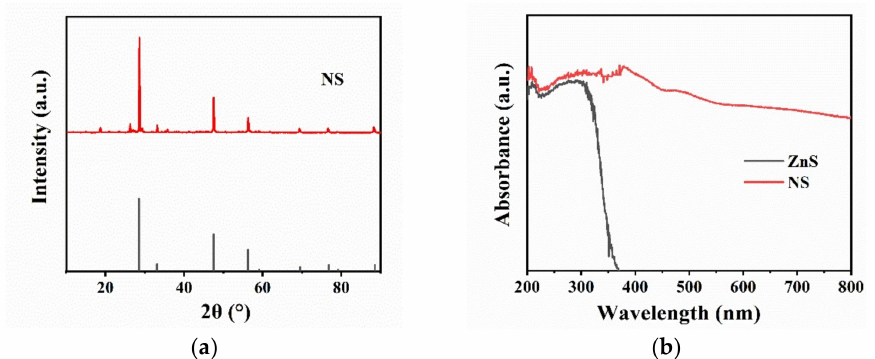
Figure 1. ( a ) X-ray diffraction (XRD) patterns of NS; ( b ) UV-visible diffuse-reflectance spectrum (UV-Vis DRS) of pure ZnS and